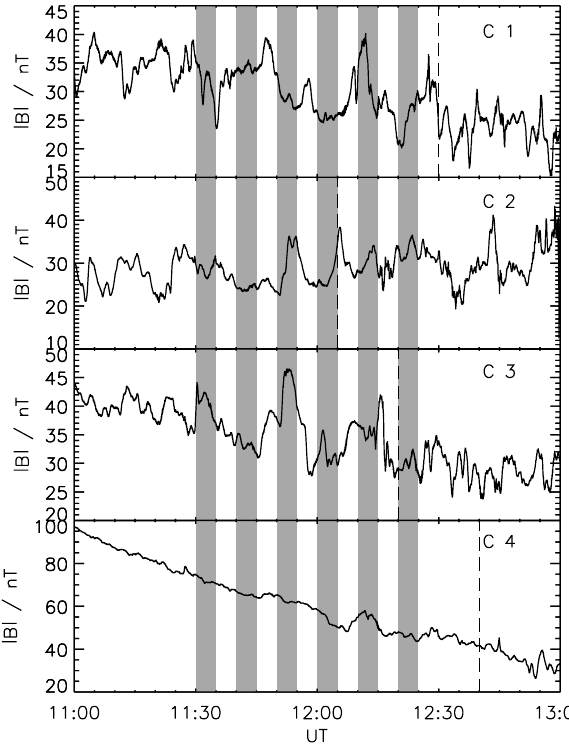
Fig. 5. Magnetic field magnitude in nT measured by the four Clus- Figure 5 ter spacecraft during 11:00–13:00UT on 1 February 2006. The grey shaded regions indicate the 5min SPEAR on times, as before. The vertical dashed line on each panel marks the estimated time of clos- est approach to the SPEAR flux tube to the nearest